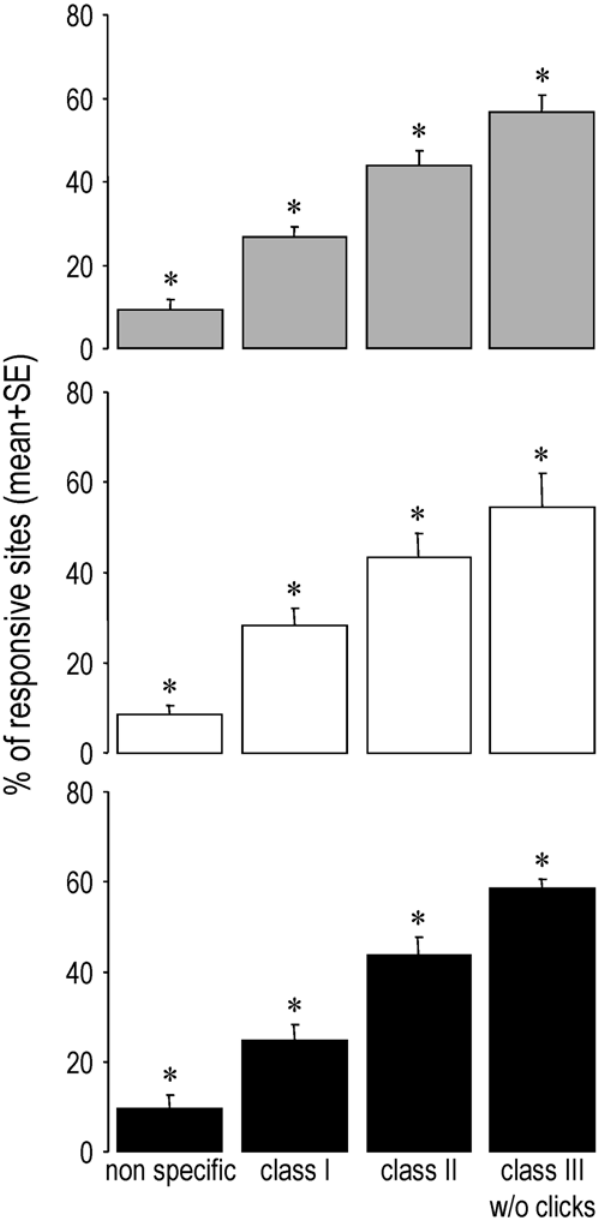
Figure 5. Mean ( 6 SE) Z scores obtained for each class of stimulus. Grey bars: pooled data of both hemispheres; white bars: data of the left hemisphere; black bars: data of the right hemisphere. * p , 0.05 compared to every other groups (PLSD Fisher tests). # p , 0.01 compared to class II and class III w/o clicks (PLSD Fisher tests). 1 p , 0.01 compared to non specific and class I (PLSD Fisher